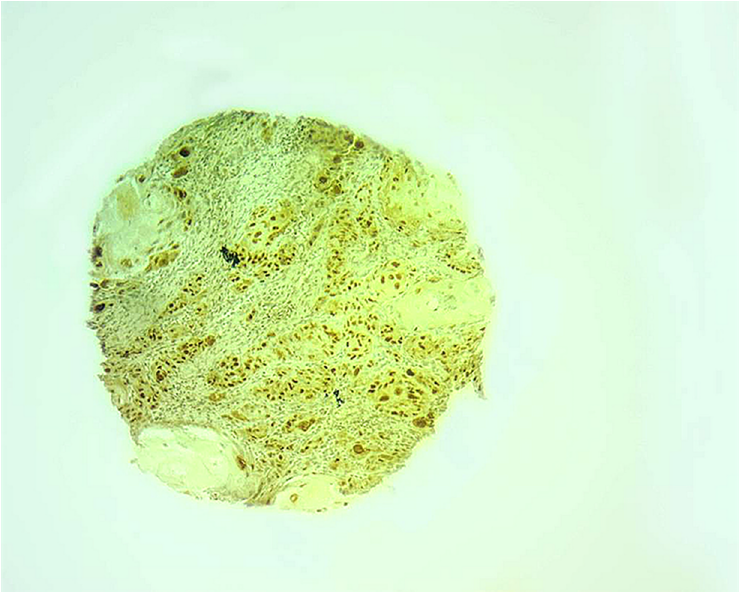
Fig 2. Microphotograph of the immunohistochemistry for p53 positive. Fig 2 shows the microphotograph of the immunohistochemistry for positive expression of